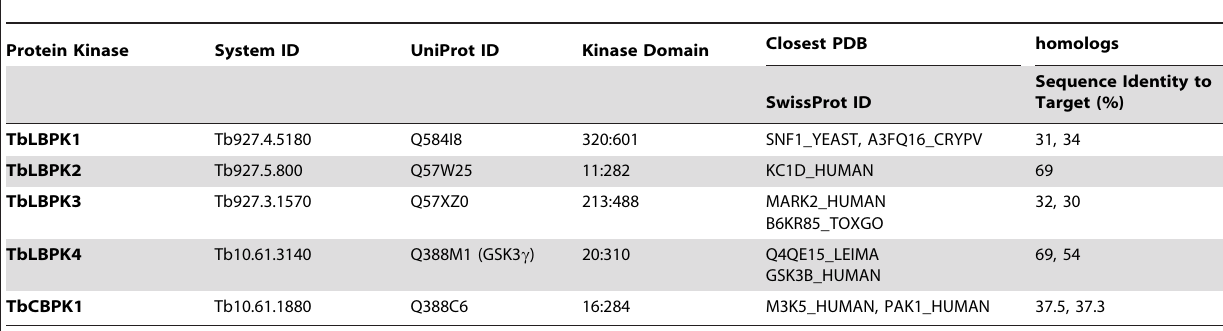
Table 2. TbLBPKs1-4 and their structural homologs in PDB.